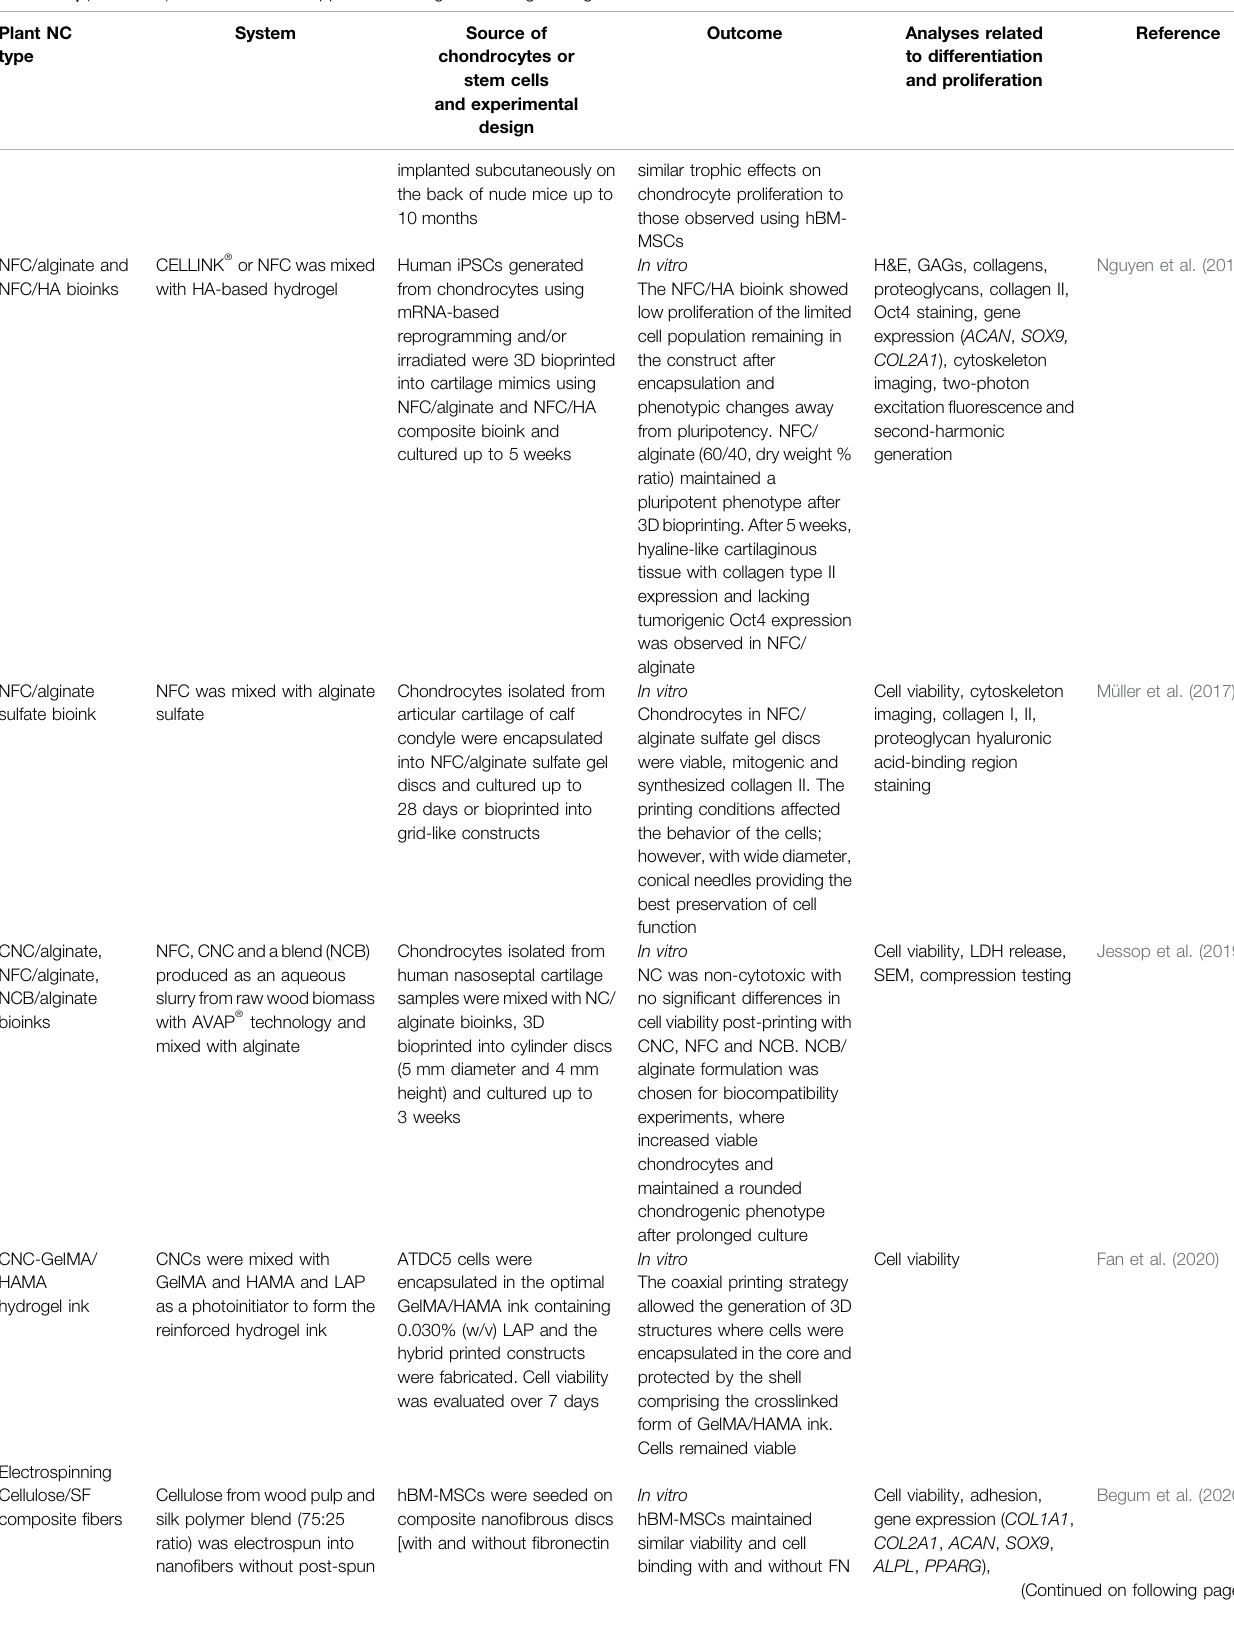
TABLE 1 | ( Continued ) Plant-derived NC applied to cartilage tissue